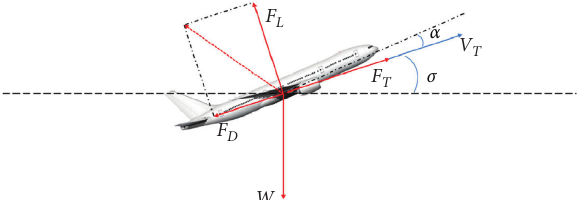
Figure 4: Forces on the